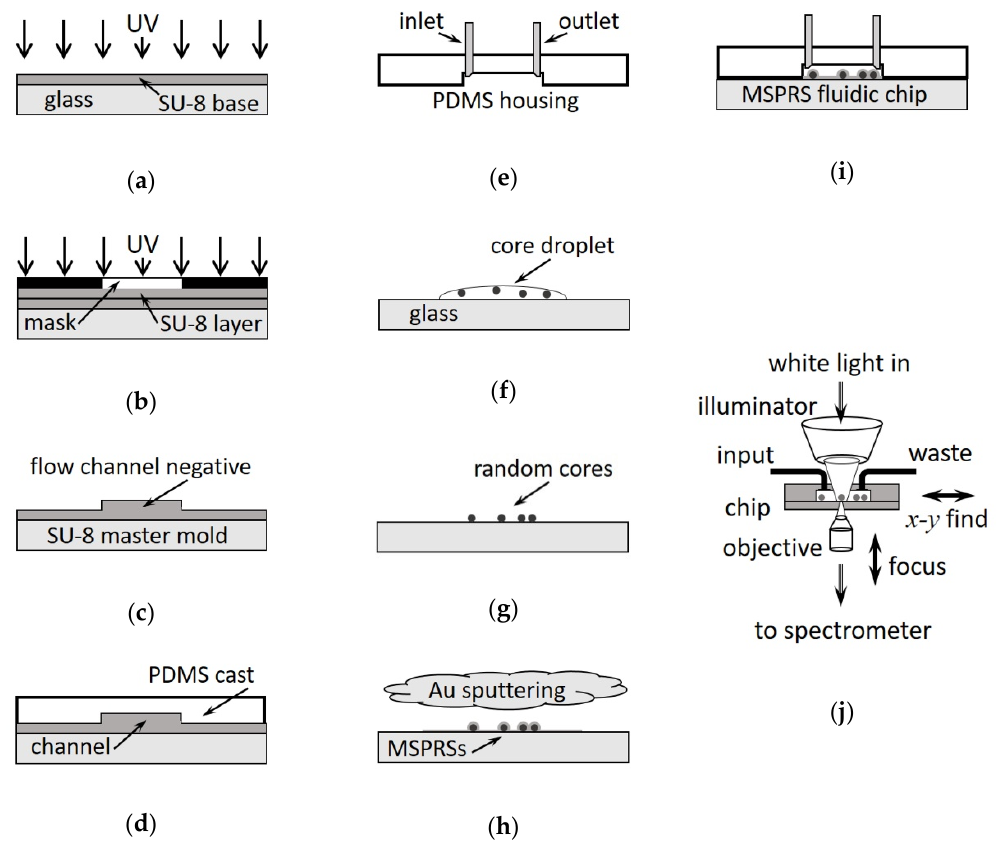
Figure 1. Main steps in microcavity surface plasmon resonance sensor (MSPRS) chip fabrication. ( a ) An adhesion SU-8 base layer was made on a clean glass slide; ( b ) The microfluidic channel pattern was transferred from a transparent mask to the second SU-8 layer; ( c ) The un-exposed SU-8 was removed. The SU-8 master mold shows the flow channel negative features; ( d ) The microfluidic housing was made by casting poly-dimethyl-siloxane (PDMS) over the SU-8 master; ( e ) Fluid inlets and outlets were bored into the PDMS housing and the tubing was attached; ( f ) The MSPRS substrate was made by dispensing a droplet of polystyrene cores on a cover glass; ( g ) This droplet was dried out revealing cores randomly distributed on glass; ( h ) Au was sputtered over both the cores and the glass substrate resulting in MSPRSs; ( i ) An MSPRS chip was made by assembling the PDMS housing from ( e ) and the MSPRS substrate from ( h ); ( j ) Schematic representation of the optical setup.